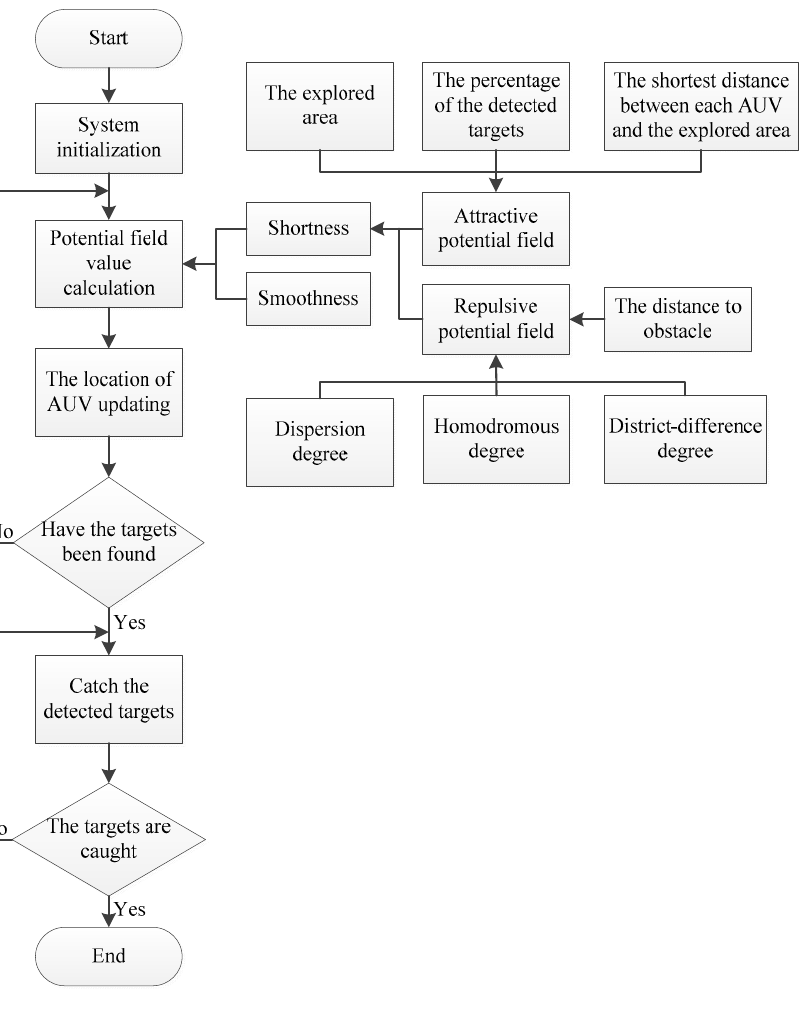
Figure 1. The flowchart for target hunting by Multiple Autonomous Underwater Vehicles (multi- AUV).